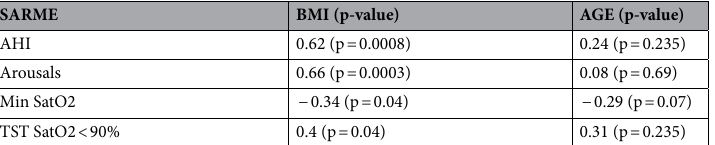
SARME BMI (p-value) AGE (p-value) AHI 0.62 (p = 0.0008) 0.24 (p = 0.235) Arousals 0.66 (p = 0.0003) 0.08 (p = 0.69) Min SatO2 − 0.34 (p = 0.04) − 0.29 (p = 0.07) TST SatO2 < 90% 0.4 (p = 0.04) 0.31 (p = Table 5. Pearson’s correlation (SARME) between BMI and AGE with AHI, arousals, minimum O2 saturation and total sleep time < 90% O2 saturation. N = 25; AHI: Apnea Hypopnea Index; Min SatO2: minimum saturation of O2); TST SatO2 < 90%: total sleep time with saturation of O2 below 90%.